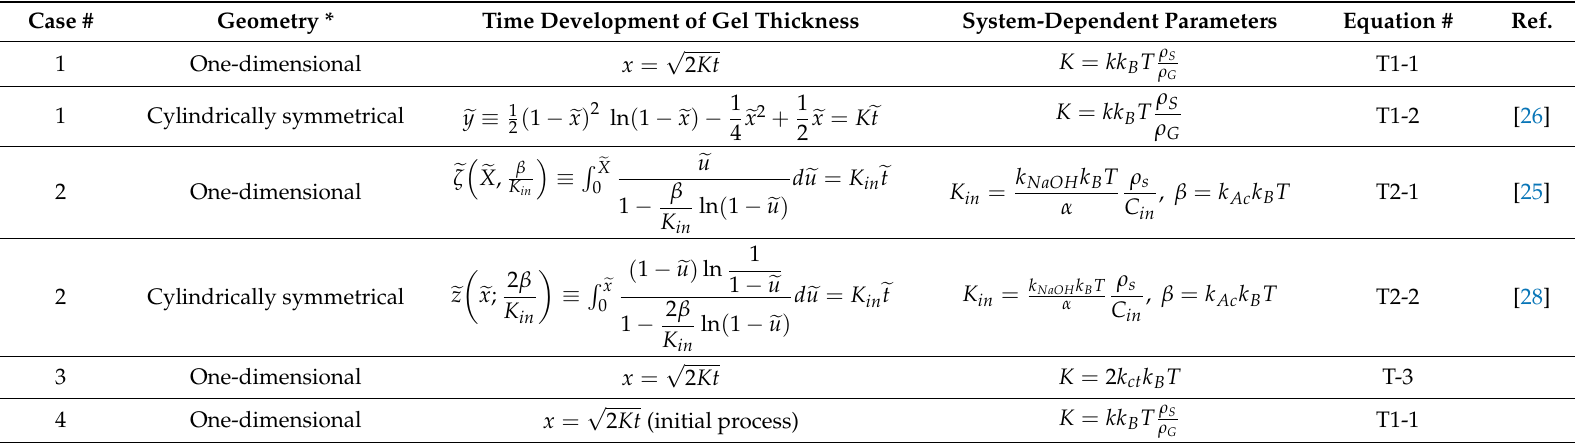
Table 1. Types of gelation and time development